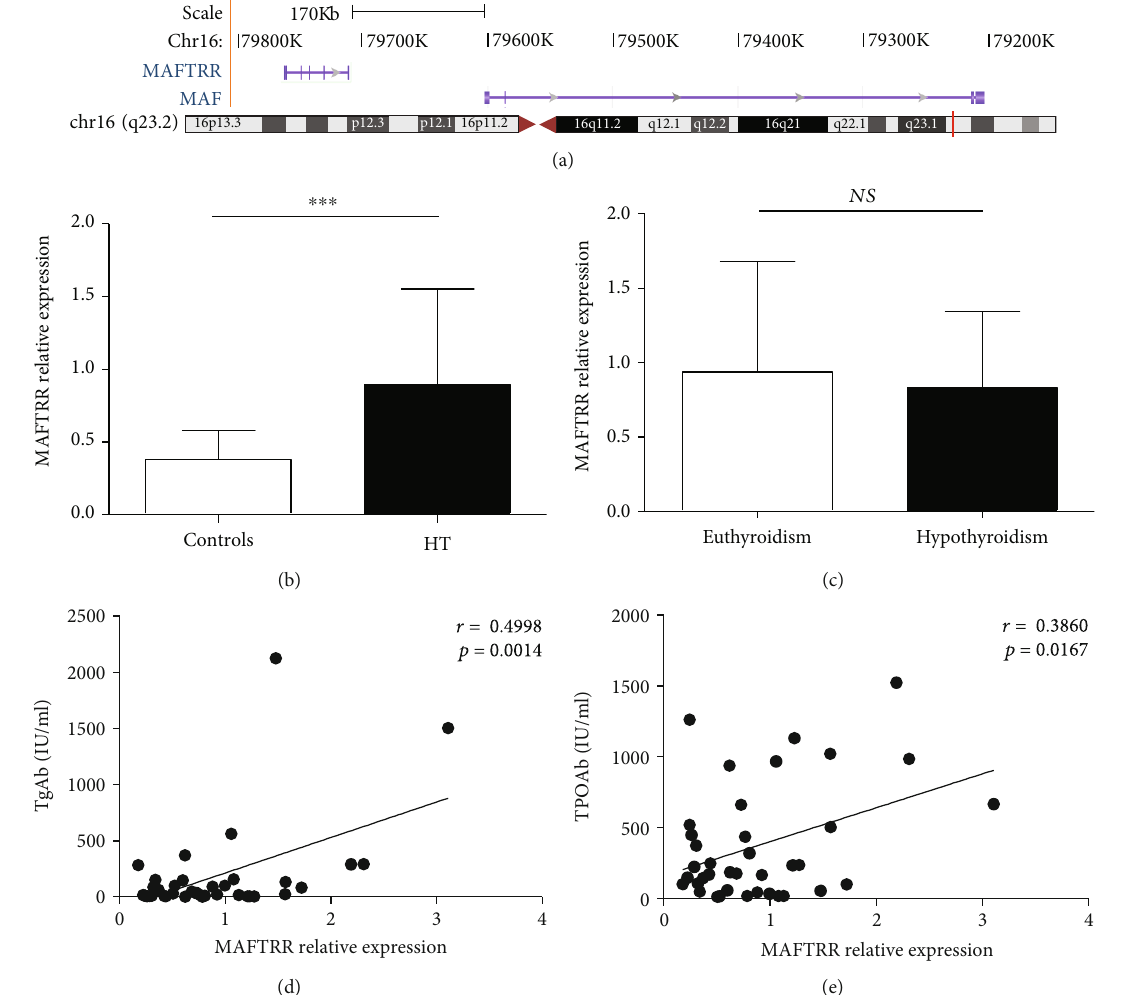
Figure 1: Increased expression of MAFTRR in PBMCs from the HT patients. (a) Genomic position of MAFTRR and MAF on human chromosome. (b) The transcript levels of MAFTRR in PBMCs from 38 HT patients and 38 healthy controls were determined by qRT- PCR. (c) The transcript levels of MAFTRR in PBMCs from the HT patients with euthyroidism and hypothyroidism were determined. The correlations between the transcript levels of MAFTRR and the serum concentrations of TgAb (d) and TPOAb (e) in the HT patients are shown. Each data point represents an individual subject, and the horizontal lines show the mean. ∗∗∗ p < 0 : 001 . NS : no signi fi